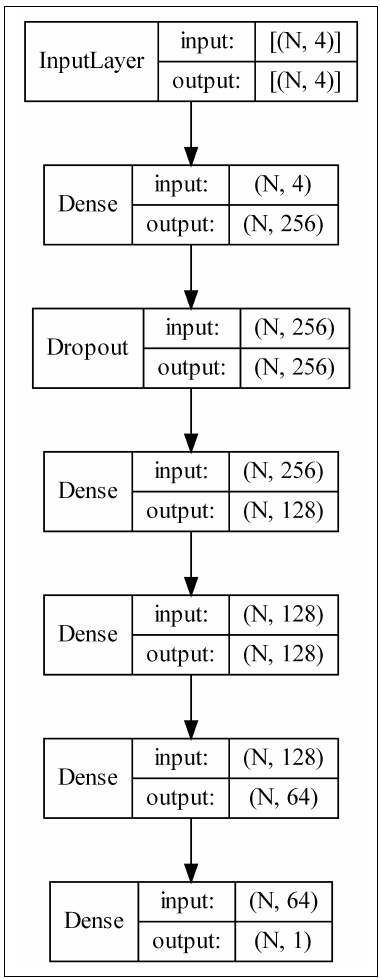
Figure 6. Structure of neural network (MLP) with tabular